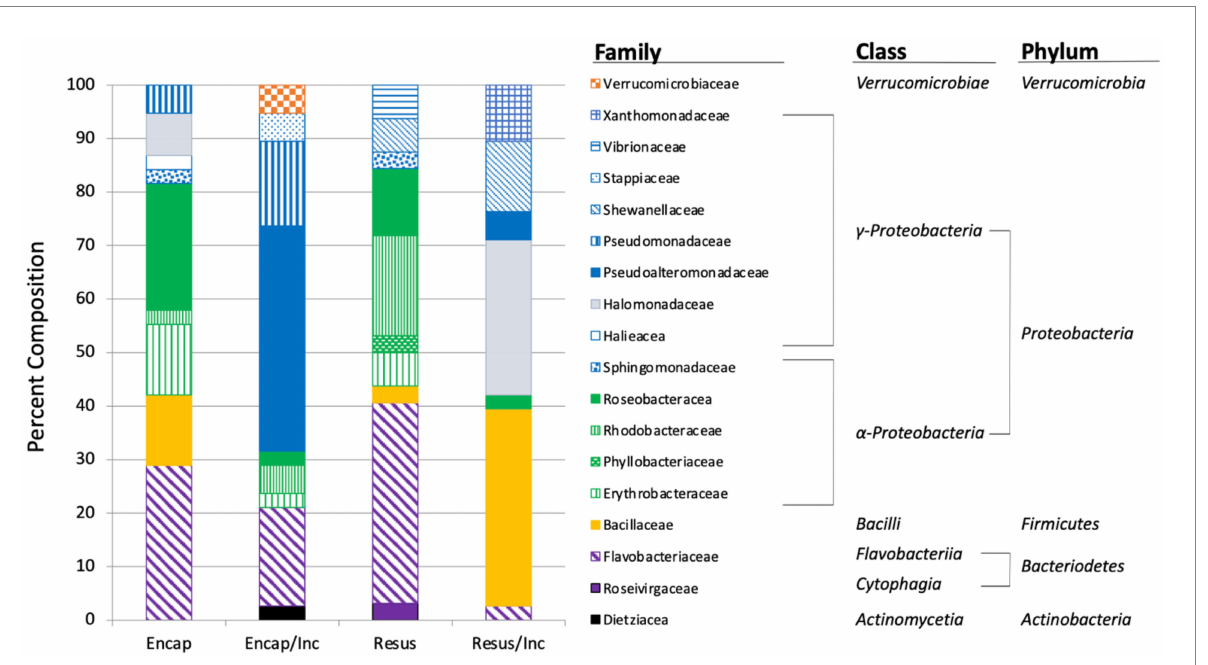
FIGURE 4 Taxonomic composition of bacteria isolated from marine sediment using four treatments: Encap: encapsulated, Encap/Inc. – encapsulated and incubated in situ , Resus – resuspended, Resus/Inc. – resuspended and incubated in situ . The bar graph shows family-level taxonomic